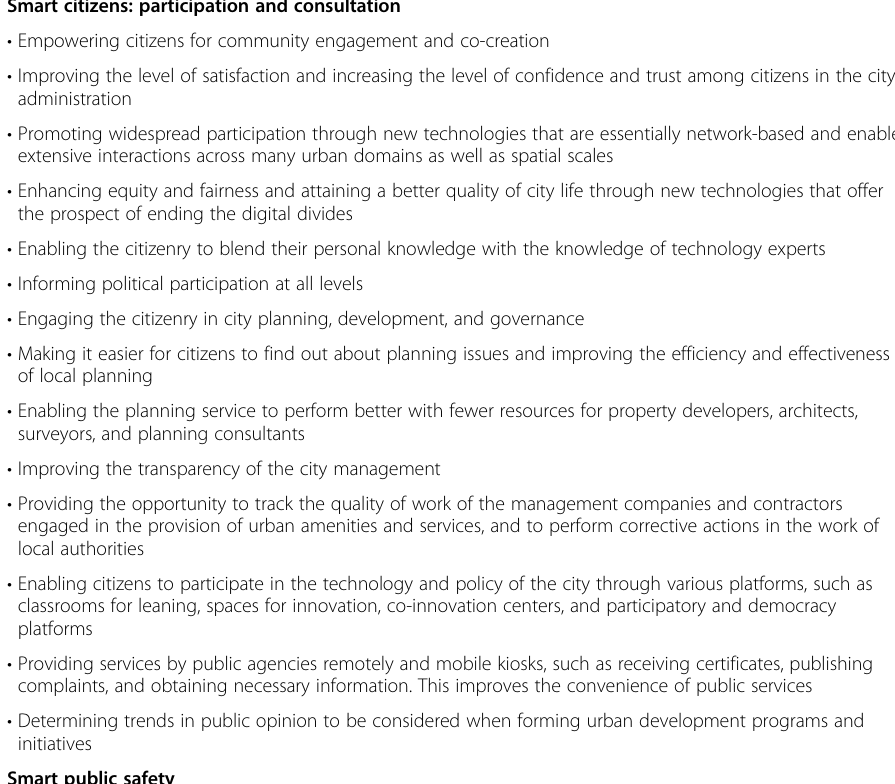
Table 6 The key benefits, potentials, and opportunities of the data-driven smart city and the environmentally data-driven smart sustainable city